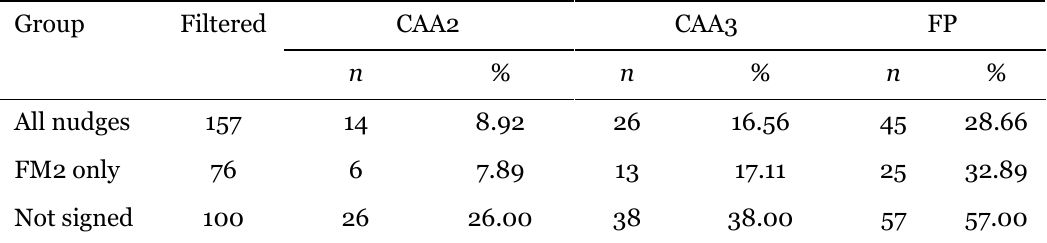
Dropout Rate for Each Group and Assessment